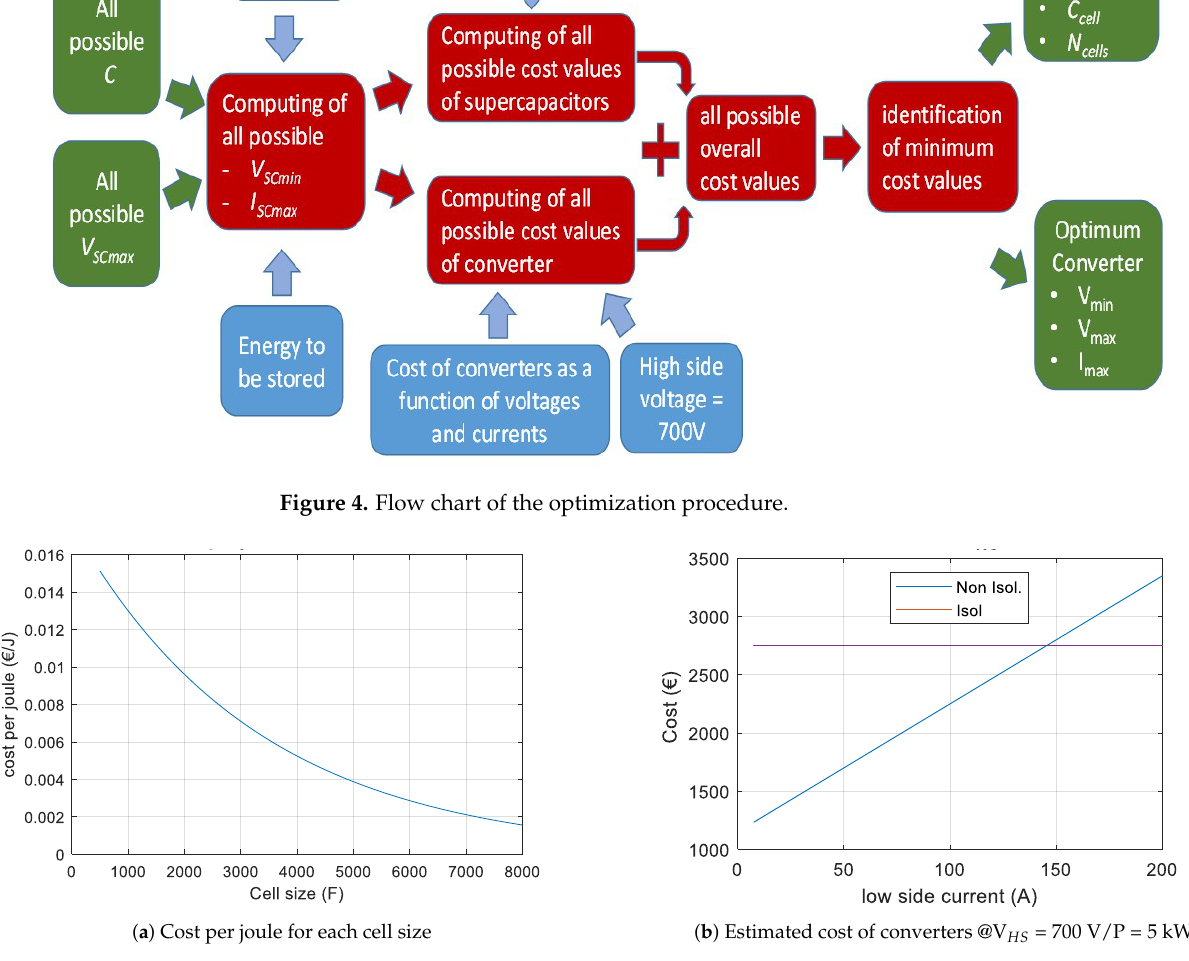
Figure 5. Cost of elements: ( a ) cost per joule for each cell size and ( b ) estimated cost of converters as a function of technology and low-voltage side